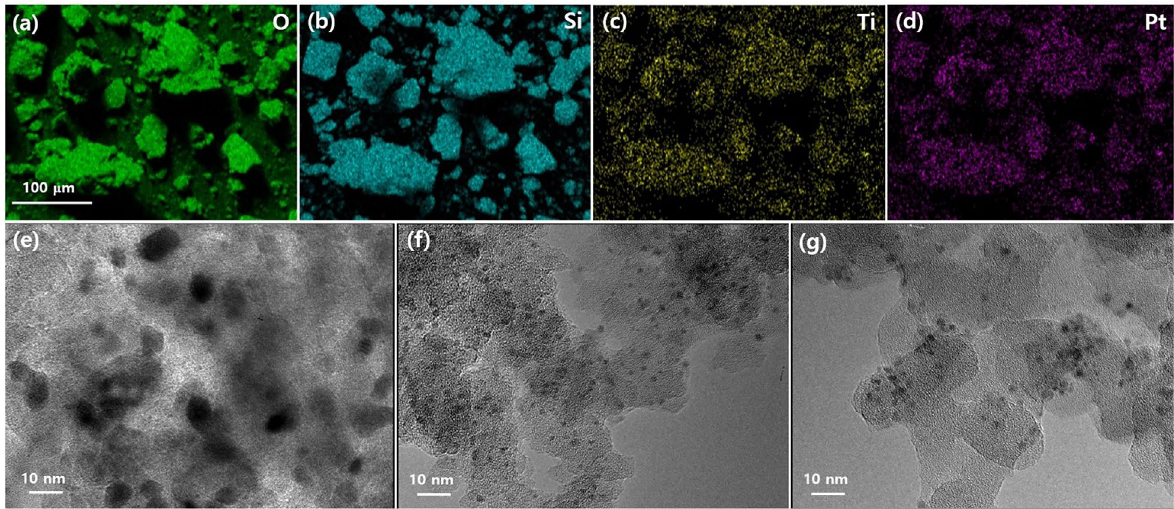
Figure 2. EDS images of H 2 O 2 -Pt/Ti–FS for ( a ) O, ( b ) Si, ( c ) Ti, and ( d ) Pt atoms. TEM images of ( e ) Pt/FS, ( f ) Pt/Ti–FS, and ( g ) H